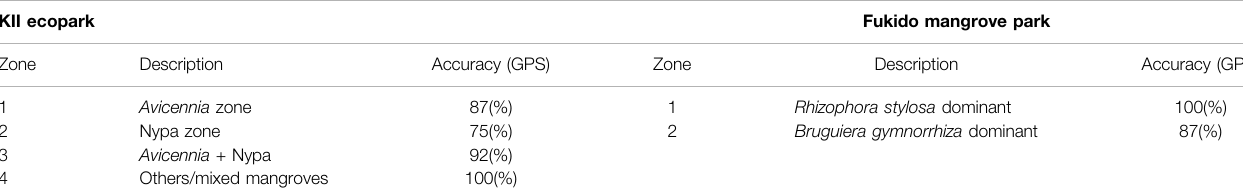
TABLE 4 | Map accuracy per mangrove zones in KII and Fukido Park using the zonation mapping work fl ow with input Sentinel-2 derived water, vegetation, and biophysical dataset. KII ecopark